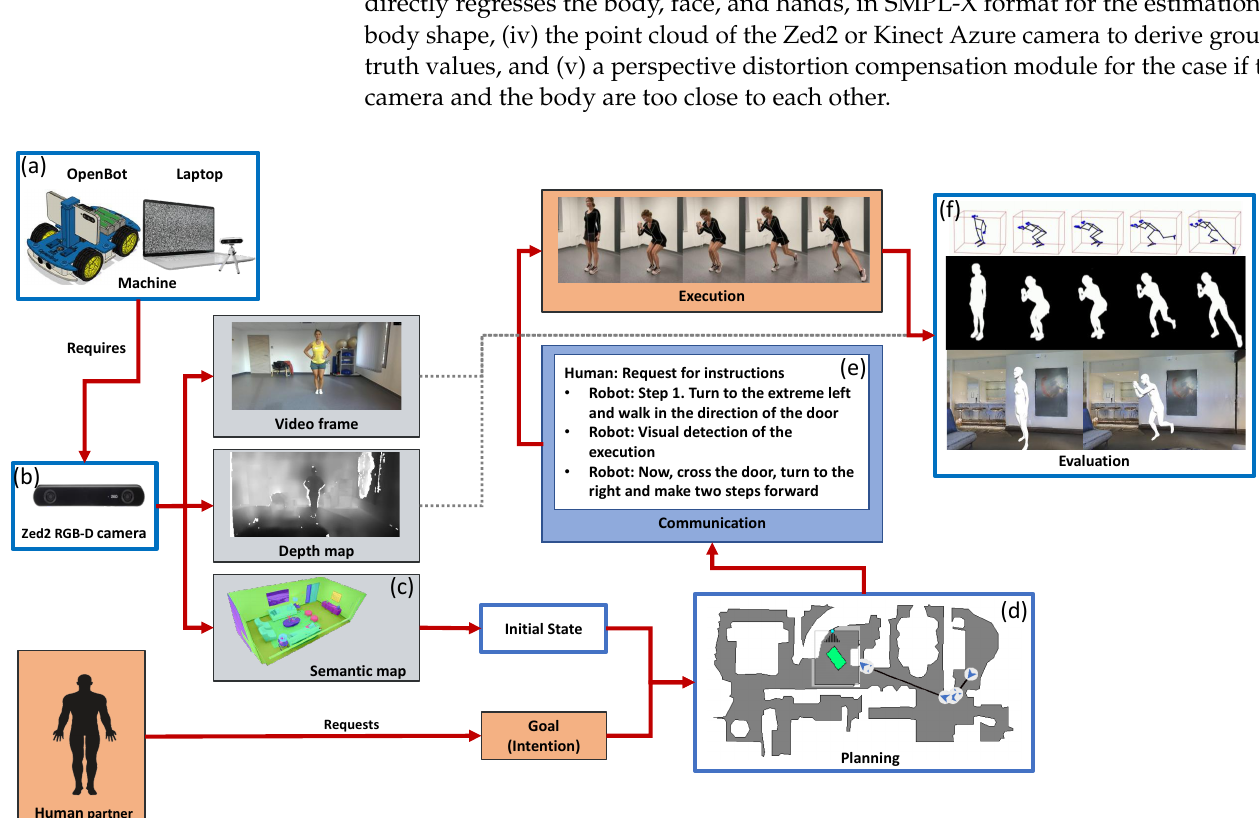
Figure 1. The Spatial Task Framework (STF) framework. Machine modules: ( a ) laptop, 3D-printed OpenBot robot [30], ( b ) Zed2 stereo or Kinect Azure ToF camera mounted on the robot base, ( c ) Simula- tion tool: Replica environments in Habitat platform [28], ( d ) a SLAM module for navigation planning, ( e ) a communication module for machine help in navigation, and ( f ) different body pose estimation methods, including an avatar for position optimization, body motion detection and evaluation (see Figure 2 for